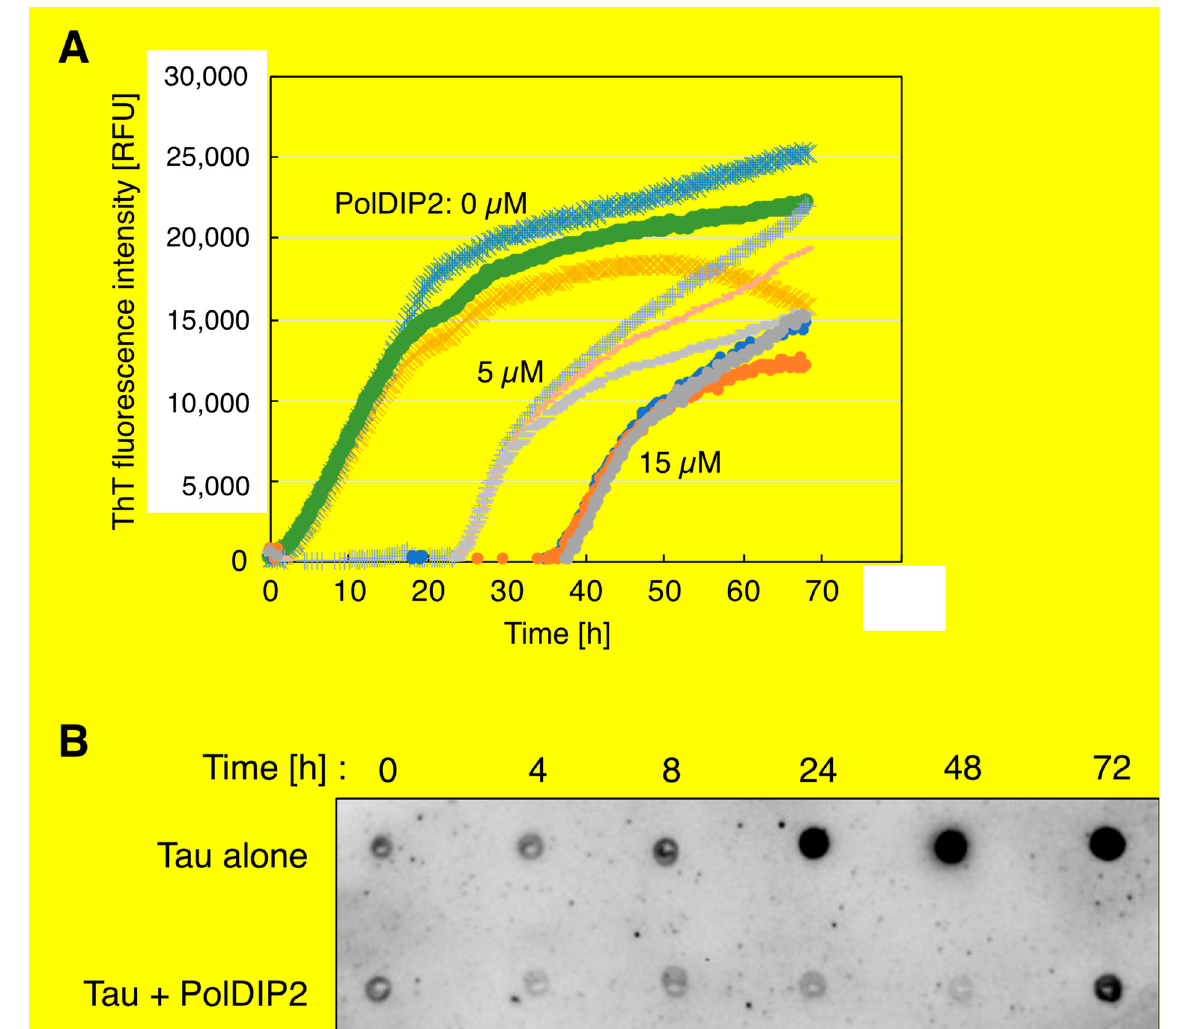
Figure 2. PolDIP2 inhibits Tau aggregate formation. ( A ) PolDIP2-dependent inhibition of Tau aggregation using ThT-based Tau aggregation assays. Tau (15 µM) and 8 µM of heparin were incubated at 37 °C in the absence or presence of 5 or 15 µM of PolDIP2 and 50 µM ThT. Reactions were done in 96-well microplates and fluorescent intensities were measured at 15 min intervals. ( B ) PolDIP2-dependent inhibition of Tau oligomer formation analyzed with a filter trap assay. Tau (15 µM), 0 or 5 µM of PolDIP2, and 8 µM of heparin were incubated at 37 °C. Reactions were done in 96-well microplates and paused at each time points (4, 8, 24, 48 and 72 h) to collect samples. Aliquots of 1 µL from the reactions were then spotted on nitrocellulose filter and analyzed by immunoblotting with Tau oligomer-specific antibody